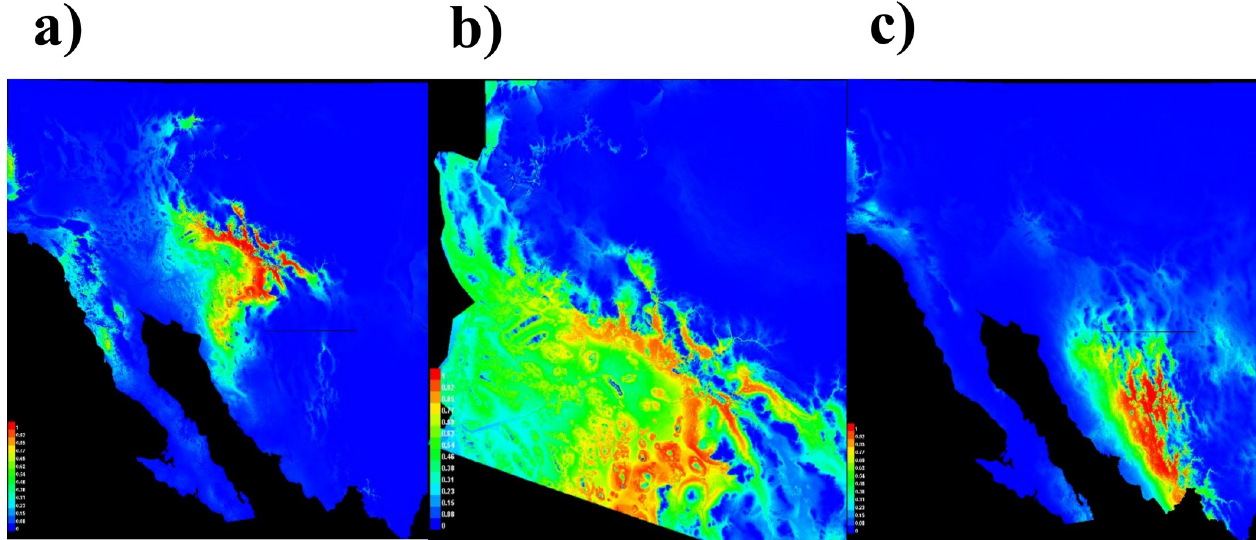
Fig 2. Suitability models for rock piles in the Sonoran Desert region (a), Arizona, USA (b), and for Agave grasslands in Sonora, Mexico (c). Coloration in red indicates high suitability potential for rock piles in (a) and (b). Coloration in red in (c) indicates high suitability for grasslands.